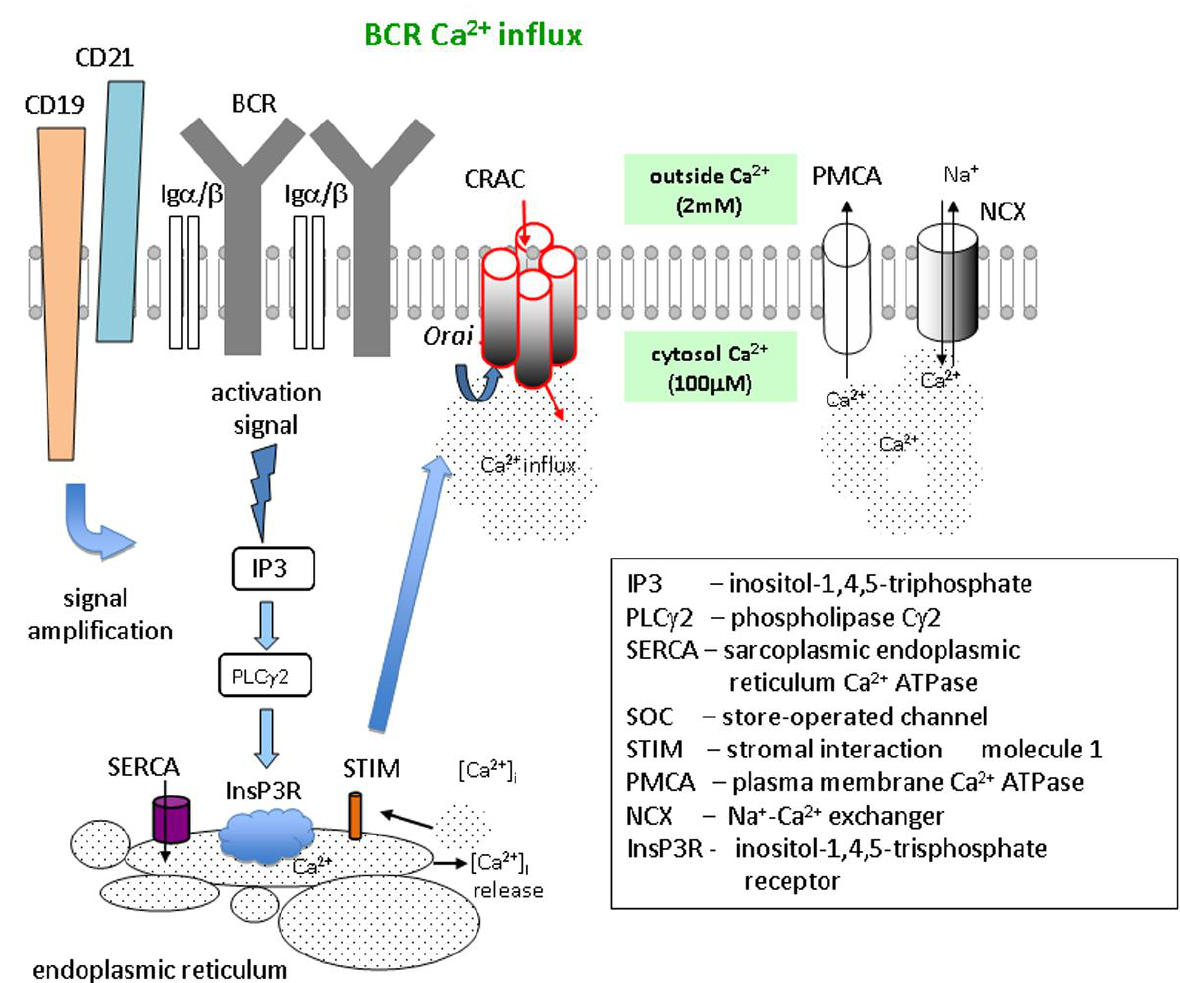
FIGURE 1. BCR-mediated Ca 2+ influx. Upon ligation/cross-linking with an antigen, the BCR signaling complex (IgM/Ig  /Ig  /CD21/CD19) elicits an activation signal mediated by IP3, PLC  2, and InsP3R, leading to rapid depletion of ER Ca 2+ stores. Ca 2+ released from the stores activates a specific type of transmembrane Ca 2+ channel (CRAC) via STIM/ Orai coupling and initiates Ca 2+ influx from the extracellular environment. PMCA and NCX represent additional regulatory mechanisms for Ca 2+